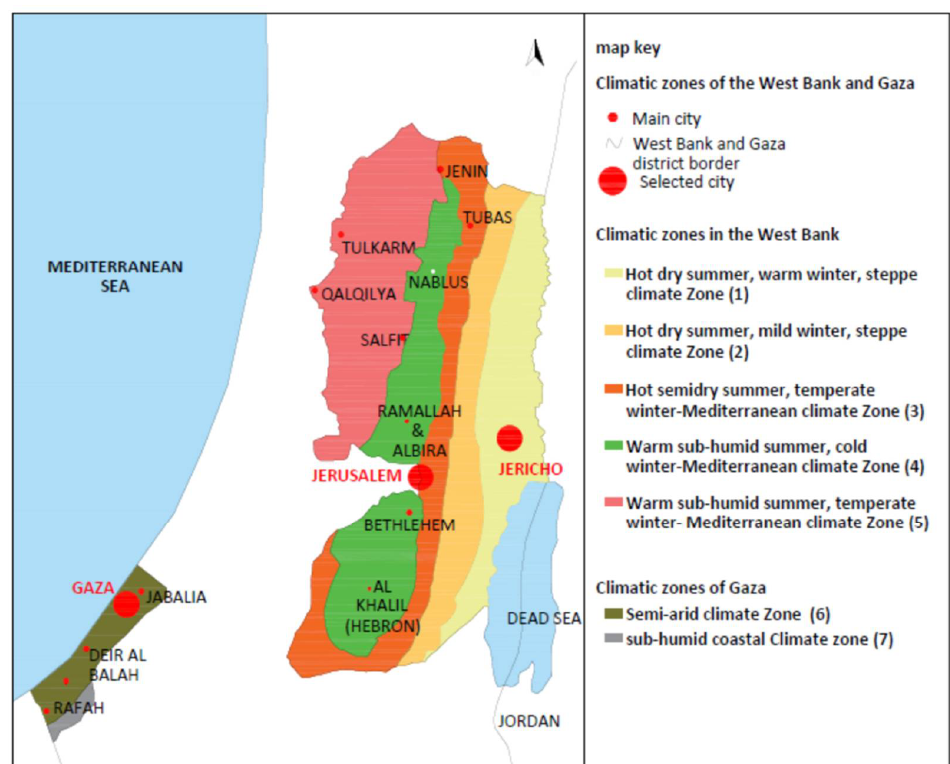
Figure 2. Climatic zones in the Palestinian territories are developed by the authors based on the information provided by Applied Research Institute—Jerusalem (source: ARIJ) [43].